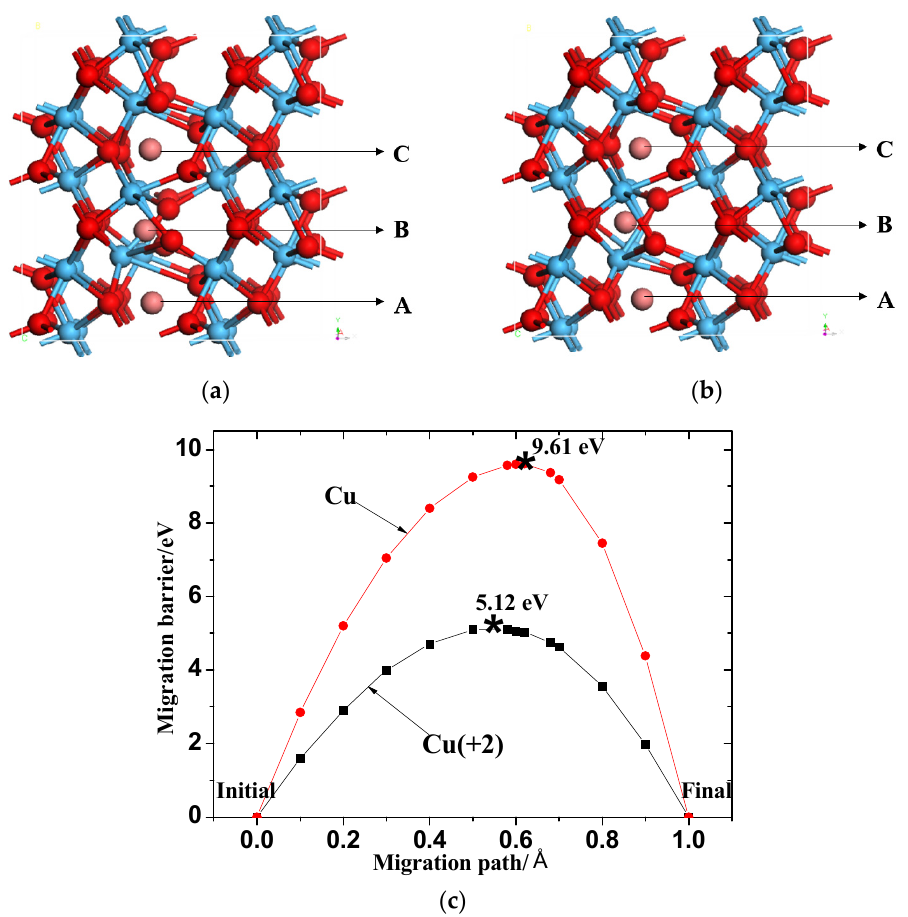
Figure 4. Migration pathway of ( a ) Cu (0) and ( b ) Cu (+2) in HfO 2 . Positions ‘A’, ‘B’, and ‘C’ represent the initial state, transition state, and final state of Cu migration, respectively (red, blue, and brown spheres represent O ions, Hf ions, and Cu ion, respectively); ( c ) Migration barrier of Cu (0) and Cu (+2) in HfO 2 .